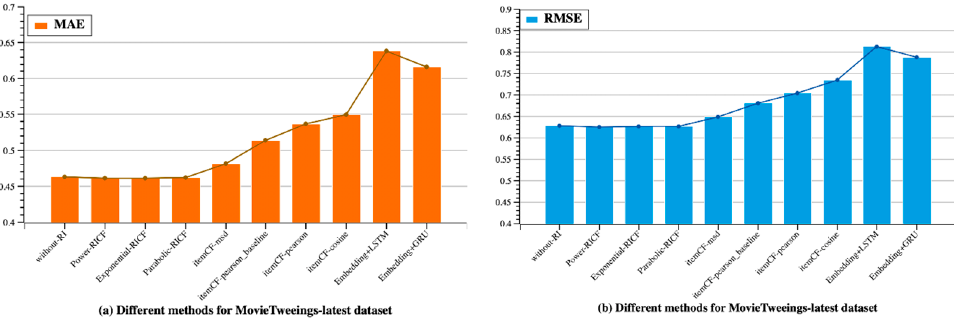
Figure 9. The evaluations of ten algorithms for MovieTweetings-latest dataset. ( a ) mean absolute error (MAE) metric; ( b ) RMSE metric.